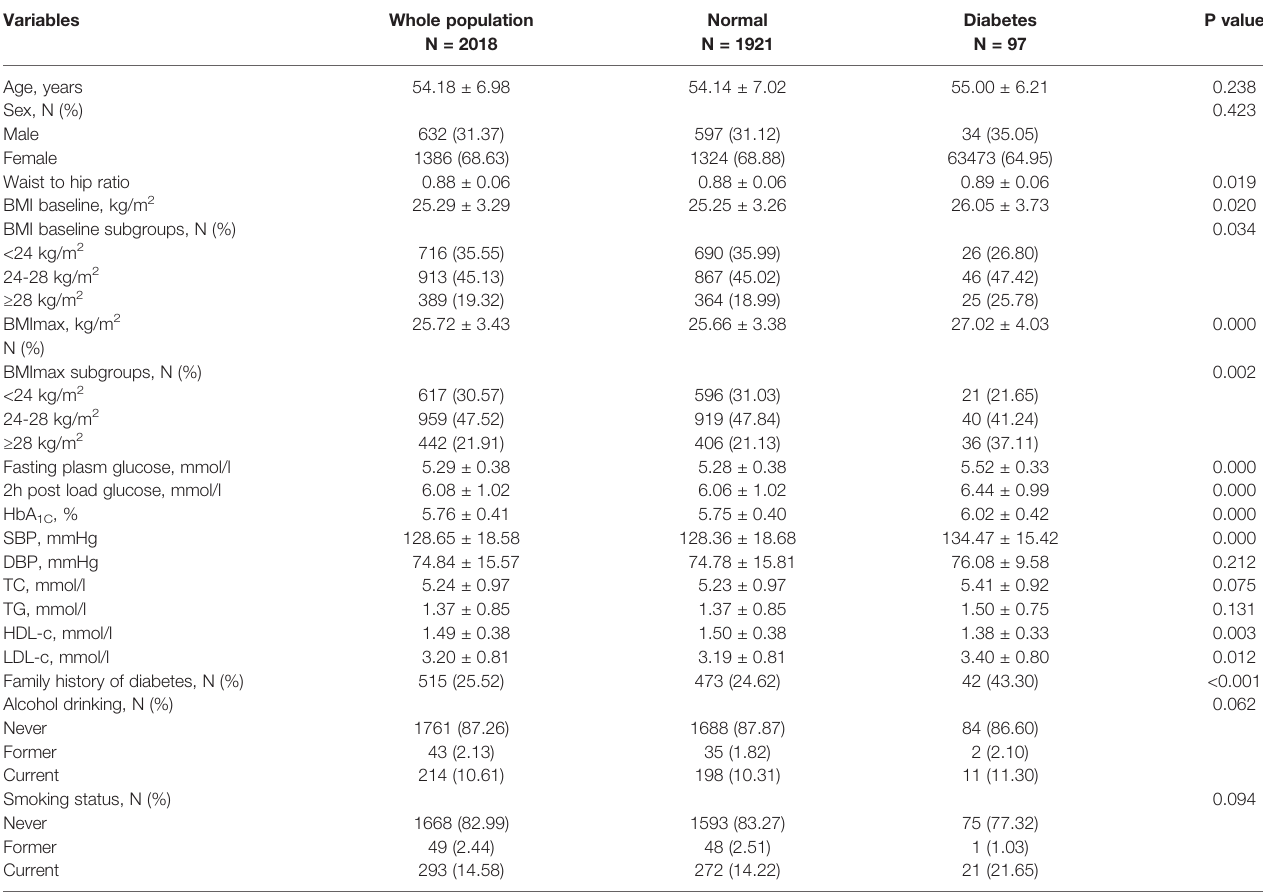
TABLE 1 | Clinical characteristics in subgroups strati fi ed by glucose outcomes at